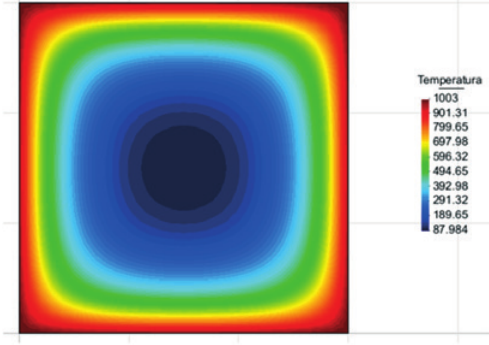
da seção 30 cm x 30 x